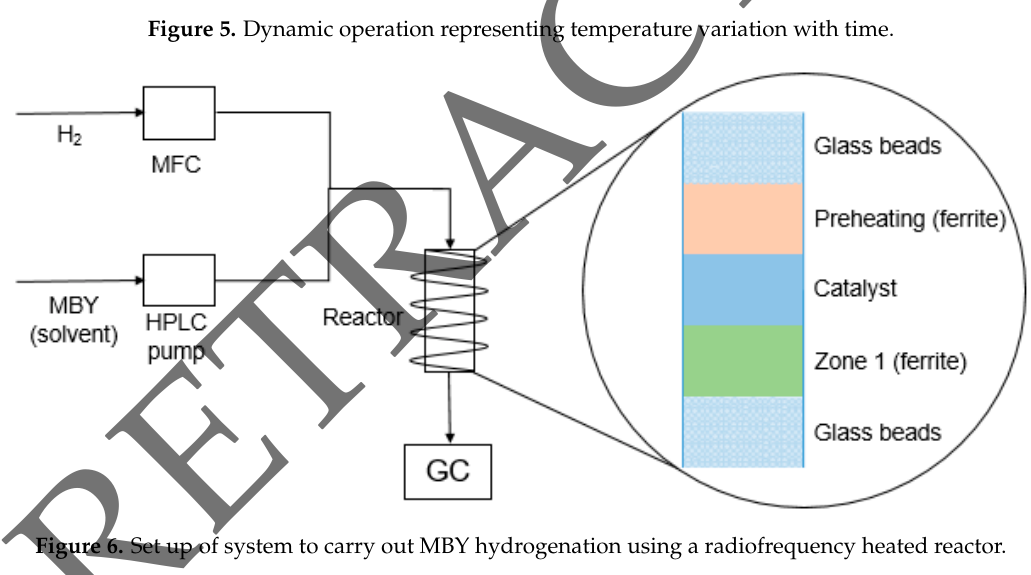
Figure 5. Dynamic operation representing temperature variation with time.